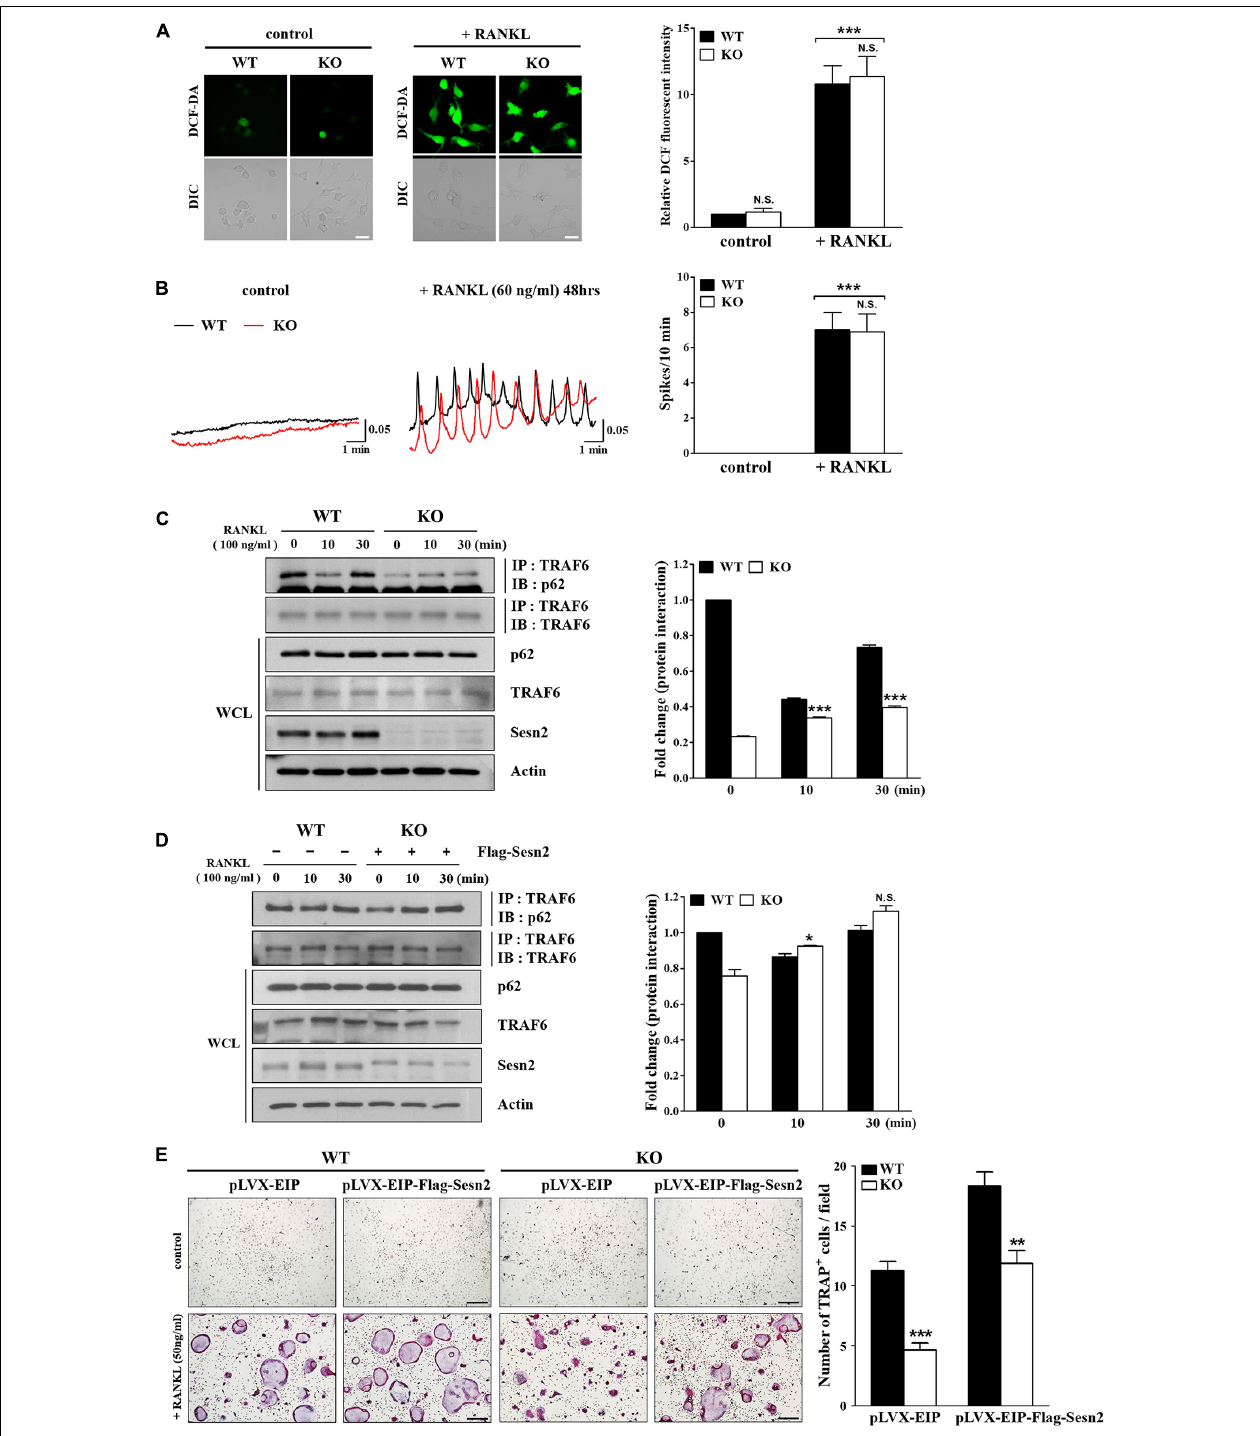
FIGURE 4 | The p62 and TRAF6 interaction is inhibited in Sesn2 KO mice. (A) RANKL-induced ROS generation was measured in WT and Sesn2 KO BMMs ( n = 7). Deletion of Sesn2 had no effect on ROS generation in Sesn2 KO BMMs. The data were normalized to the amount of ROS generated in WT cells and expressed as mean ± S.E.M. *** p < 0.001 compared with control. N.S. = not significant (Scale bar = 10 µ m). (B) The number of RANKL-induced [Ca 2 + ] i oscillations were measured in WT and Sesn2 KO BMMs ( n = 5). Deletion of Sesn2 had no effects on [Ca 2 + ] i oscillations. The data were expressed as means ± S.E.M. *** p < 0.001 compared with control. N.S. = not significant. (C) BMMs from WT and Sesn2 KO mice were treated with RANKL for the period indicated, immunoprecipitated with anti-TRAF6 antibody, and the precipitates were immunoblotted for p62 (55 kDa) and TRAF6 (60 kDa; n = 3). The Sesn2 deletion inhibited the interaction